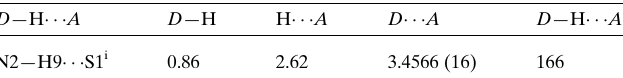
Figure 3 Synthesis of the title compound.